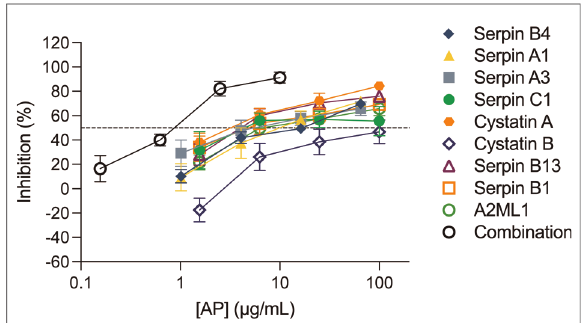
FIGURE 2 Combination of nine antiproteases in ecto-cervical explants are more active against HIV-1 BaL than each individual drugs. The dose-response curve of each antiprotease (AP) was compared with than of the combination of the nine APs. The percentage of inhibition by each AP and by the combination was normalized relative to the p24 values obtained for ecto-cervical explants not exposed to virus (0% infectivity) and for explants infected with virus in the absence of APs (100% infectivity). Data are means (± SEM) from at least two independent experiments performed in triplicate. Dashed line represents 50% of